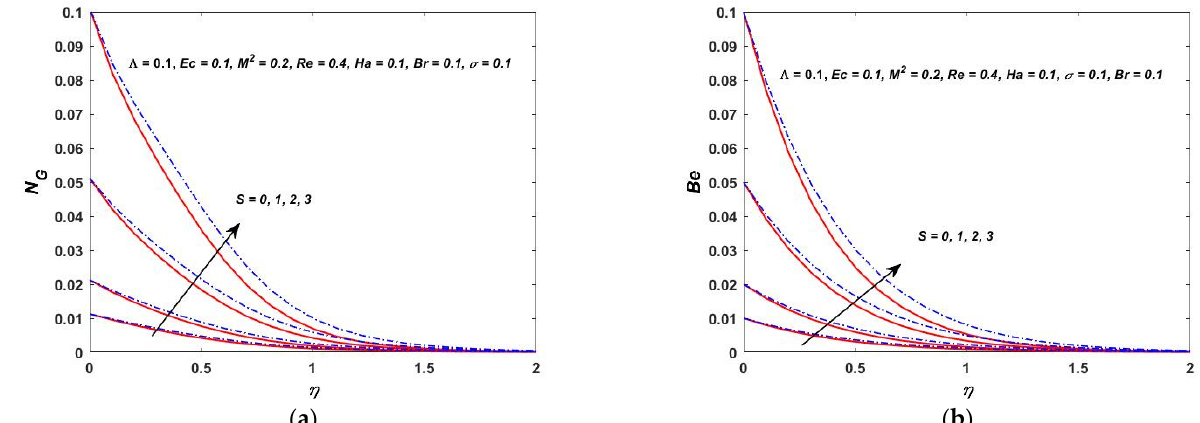
Figure 25. ( a ) Rotation verses entropy 𝑁 (cid:3008) . ( b ) Rotation verses Bejan (Be).